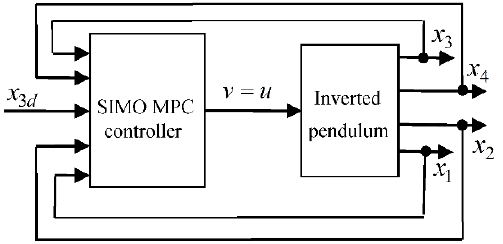
Figure 3. The proposed CIP SIMO MPC control system.